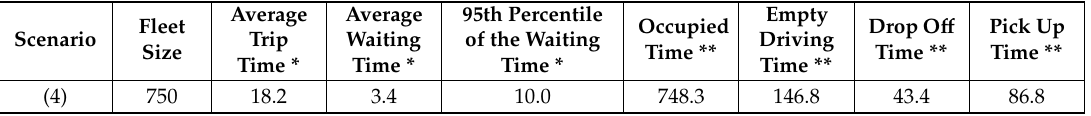
Table 5. Trip time components of the travelers for scenario (4), when an AV fleet was used.